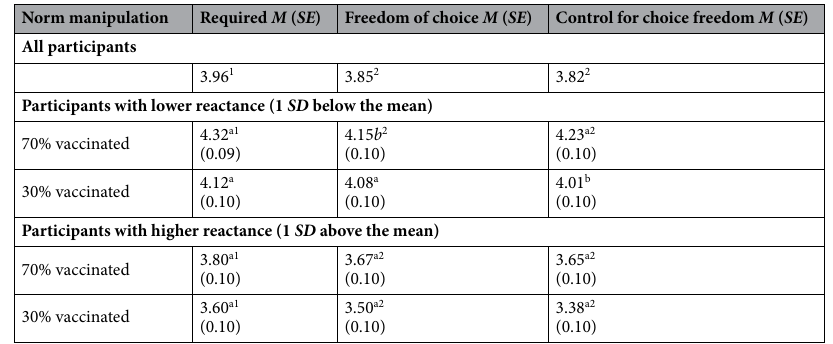
Table 3. Effects of requiring vaccination, norms, and psychological reactance on vaccination intentions: Study 3. Within each estimated level of reactance, different letter supscripts indicate significant differences across the required, freedom, and control for choice freedom conditions, and different number supscripts indicate significant differences between the two levels of norms. Intentions were measured on a 1–5 scale, where 1 = extremely unlikely, 2 = somewhat unlikely, 3 = neither likely nor unlikely, 4 = somewhat likely, and 5 = extremely likely.